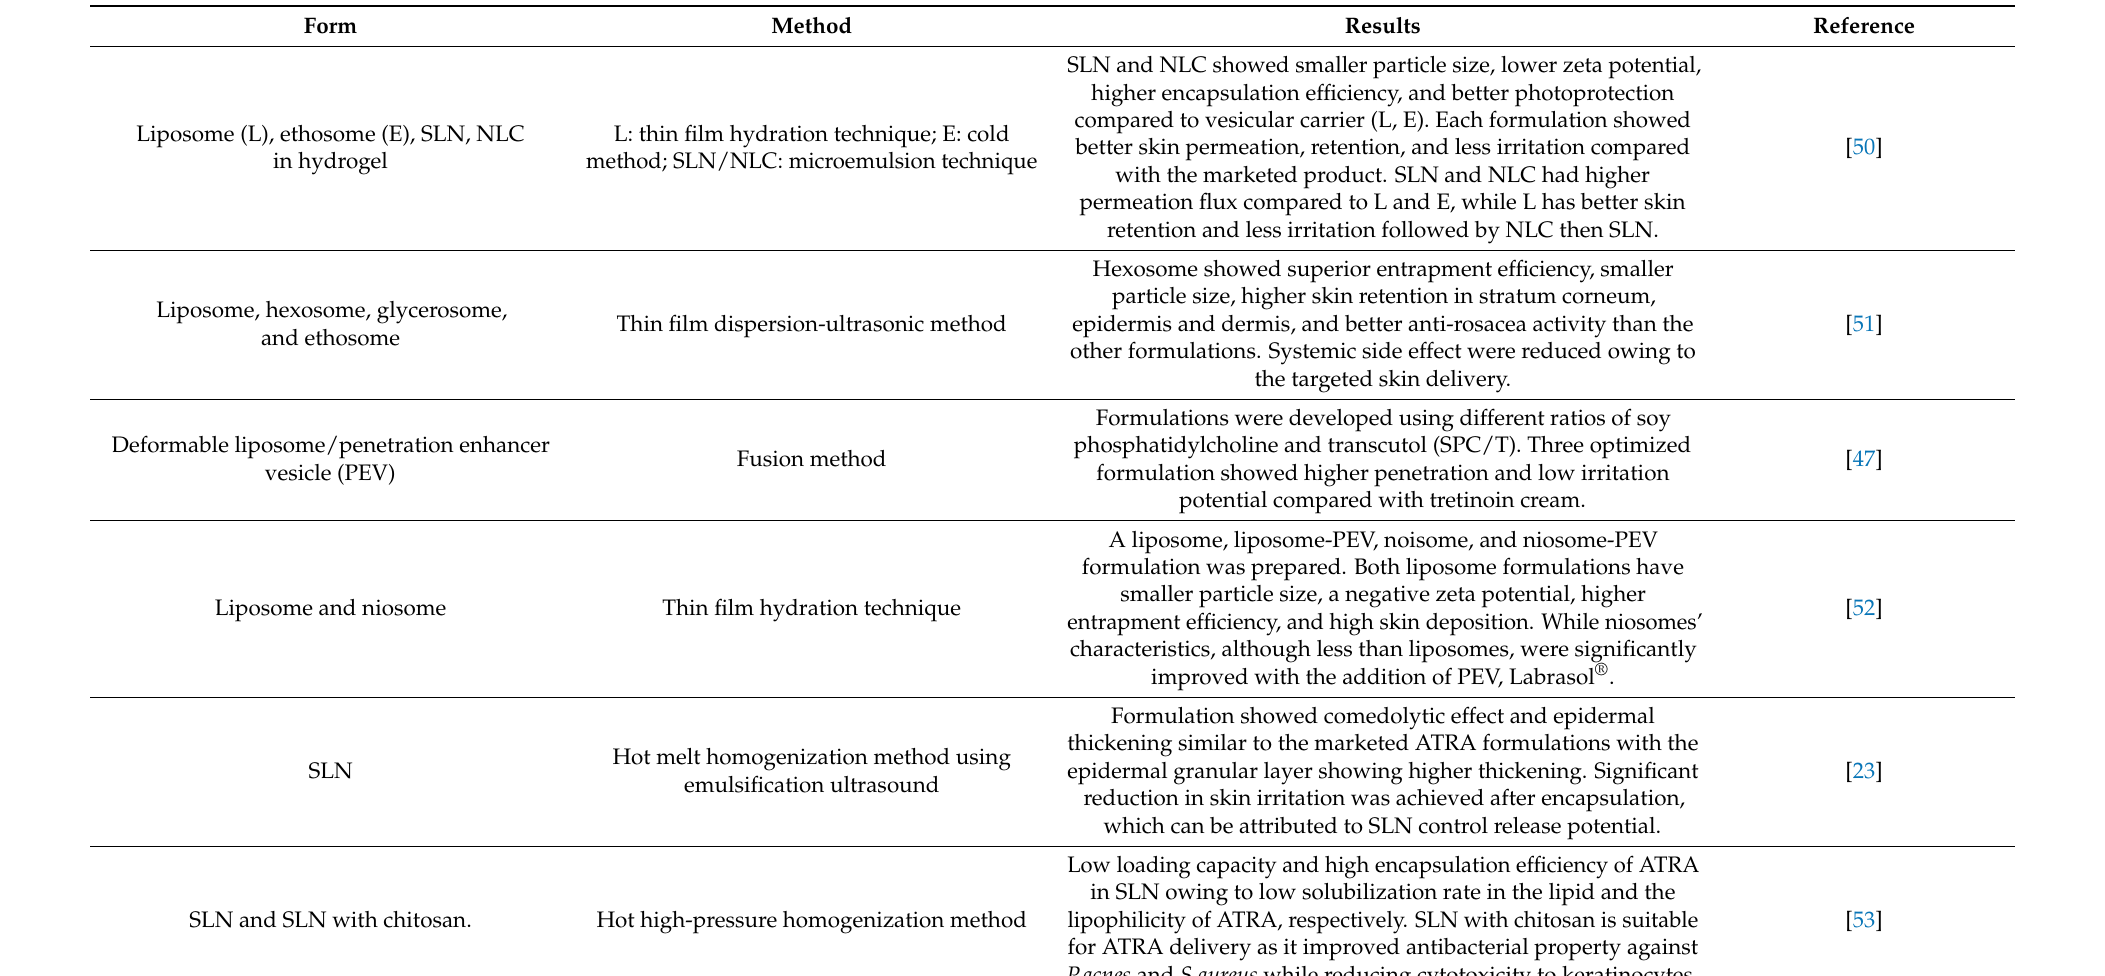
Table 2. Delivery systems used to encapsulate